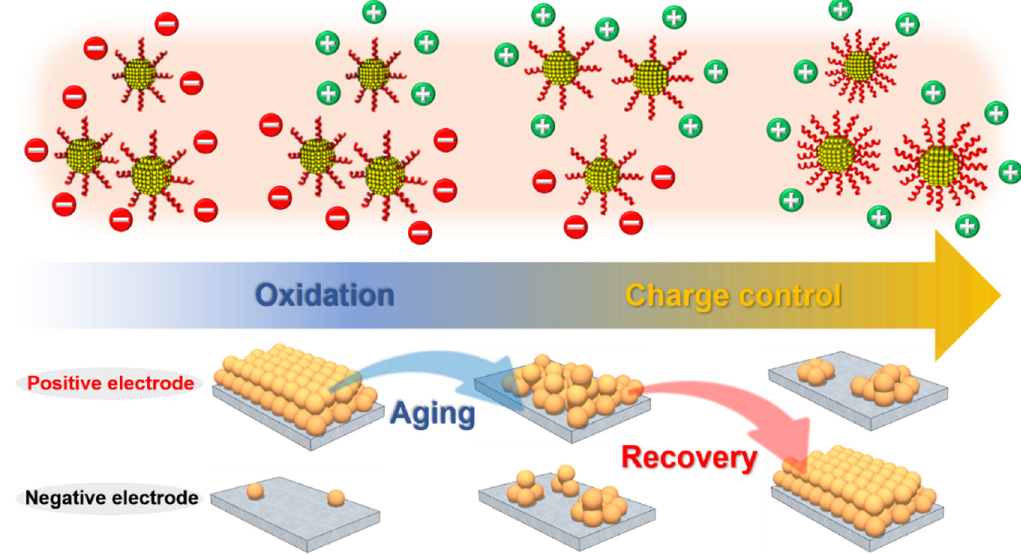
depending upon the aging and recovery process.